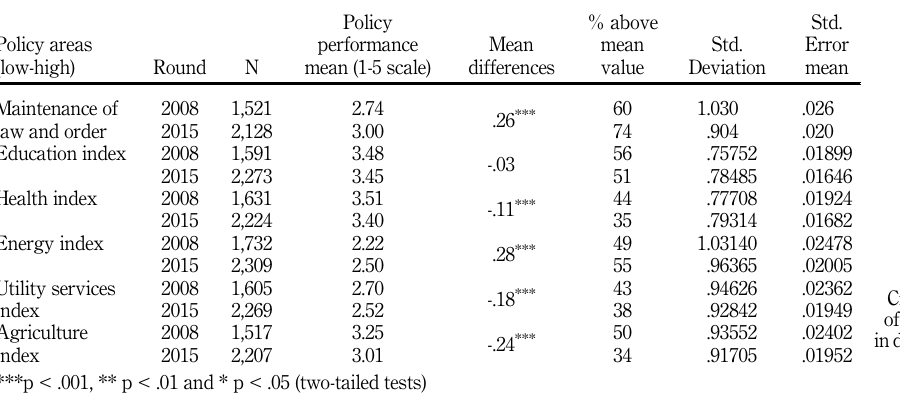
Table 14. Citizens ’